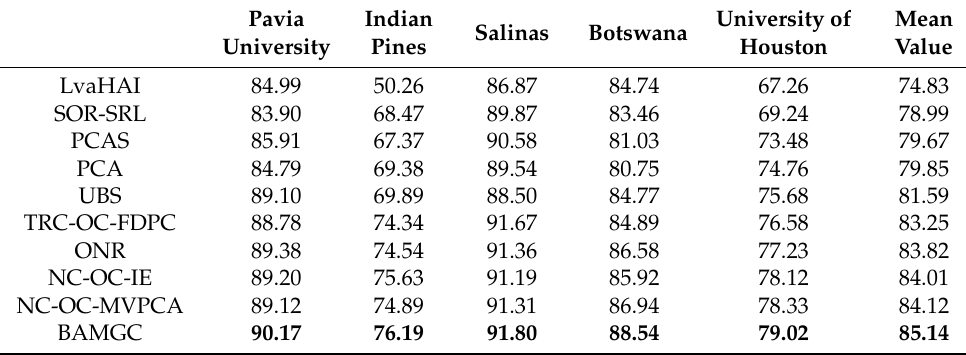
Table 5. The table illustrates the weighted mean of OA when SVM is